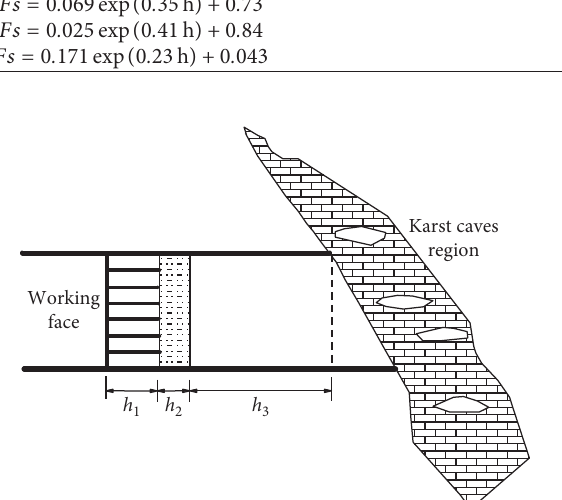
Figure 19: Schematic diagram of safety thickness of water-proof rock pillar setting in mining engineering. Table 3: Safety thickness of water-proof rock pillar setting in the Maokou limestone for the Qiyi coal mine. Kars water pressure